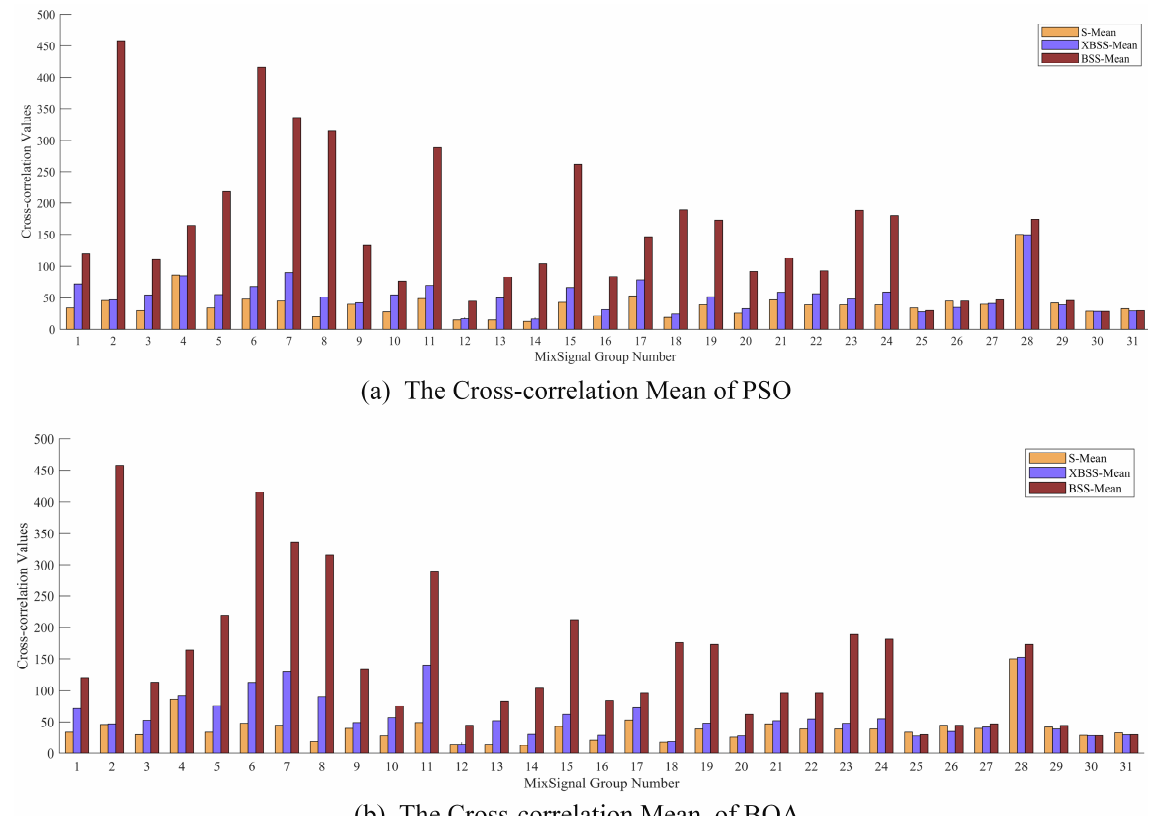
Figure 12. The mean cross-correlation between PSO and BOA. S-Mean is the cross-correlation between source signals. XBSS-Mean is the mean cross-correlation of separated signals obtained by PSO-XBSS and BOA-XBSS. BSS-Mean is the mean of cross-correlation between separated signals obtained by BSS based on PSO-BSS and BOA-BSS.